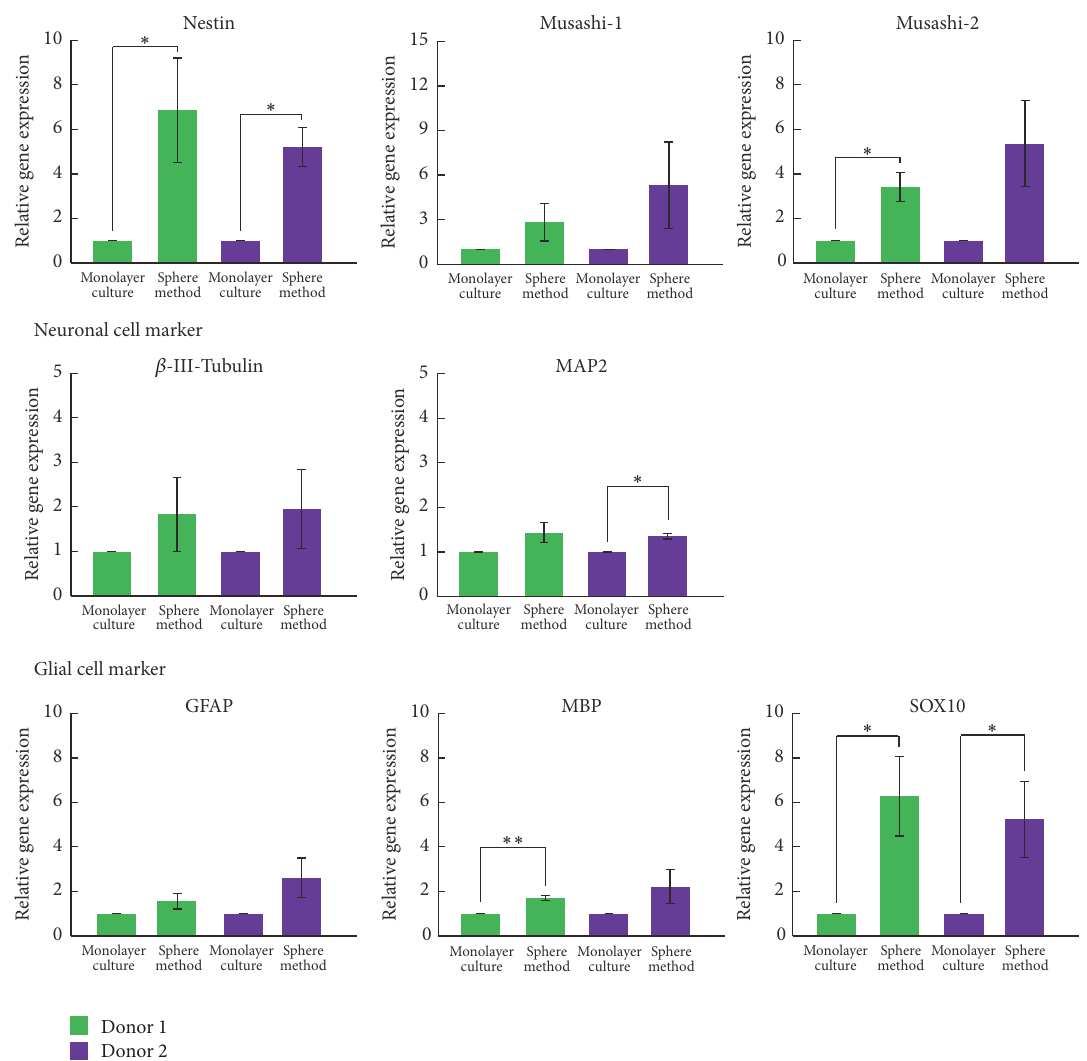
Figure 6: Analysis of gene expression of neural markers after neurosphere formation in hDFCs isolated from two patients. Gene expression was examined in hDFCs in monolayer culture and the neurosphere. Values represent the means ± SD (𝑛 = 3) . ∗ 𝑝 < 0.05 , ∗∗ 𝑝 < 0.01